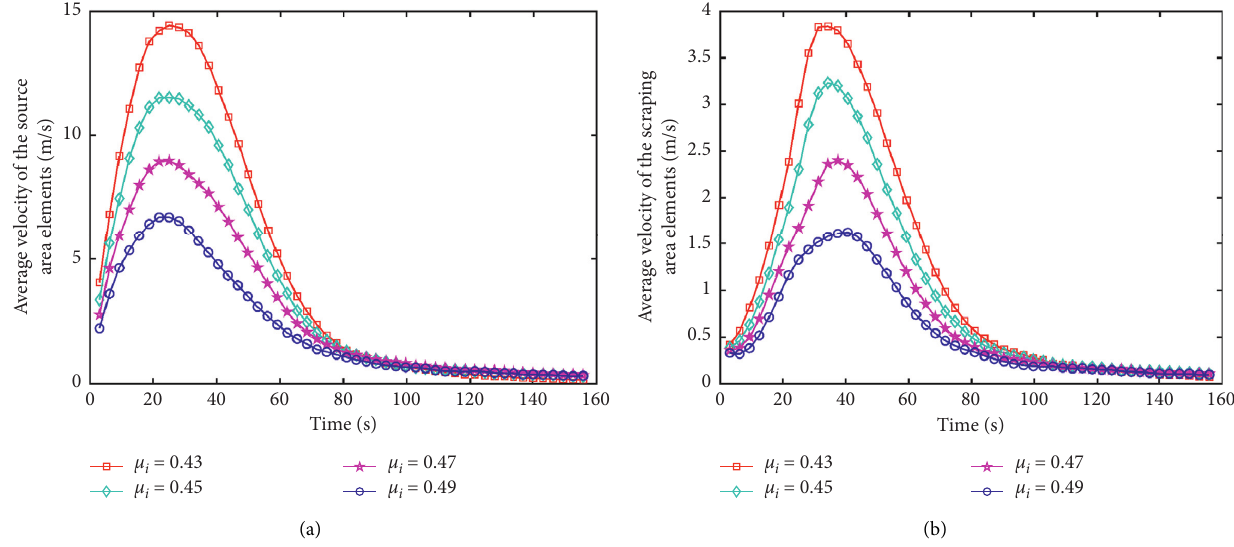
Figure 18: The average velocity of the (a) source area and (b) scraping area elements under different internal friction coefficients.